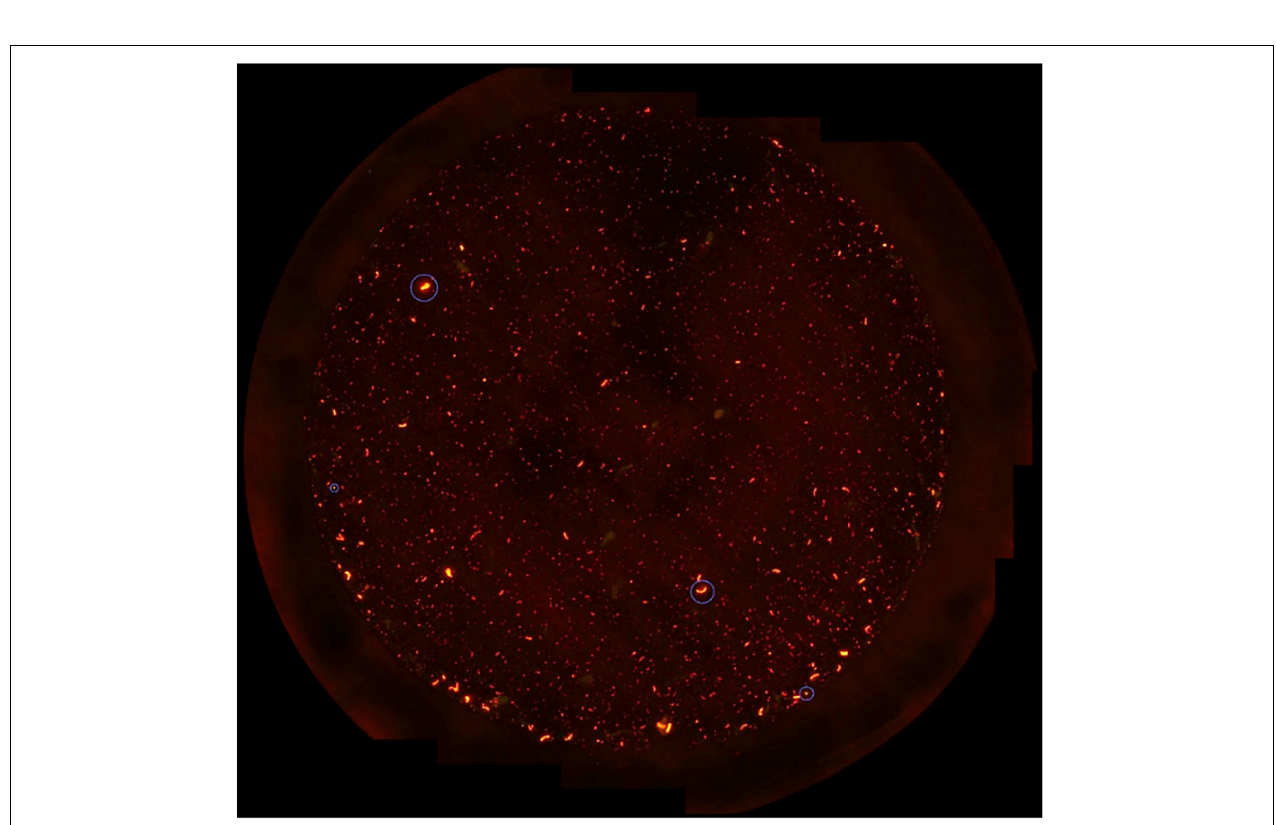
FIGURE 6 | Imaging analysis of individual sample 2 of Platichthys flesus from BPNS stained with Nile red.